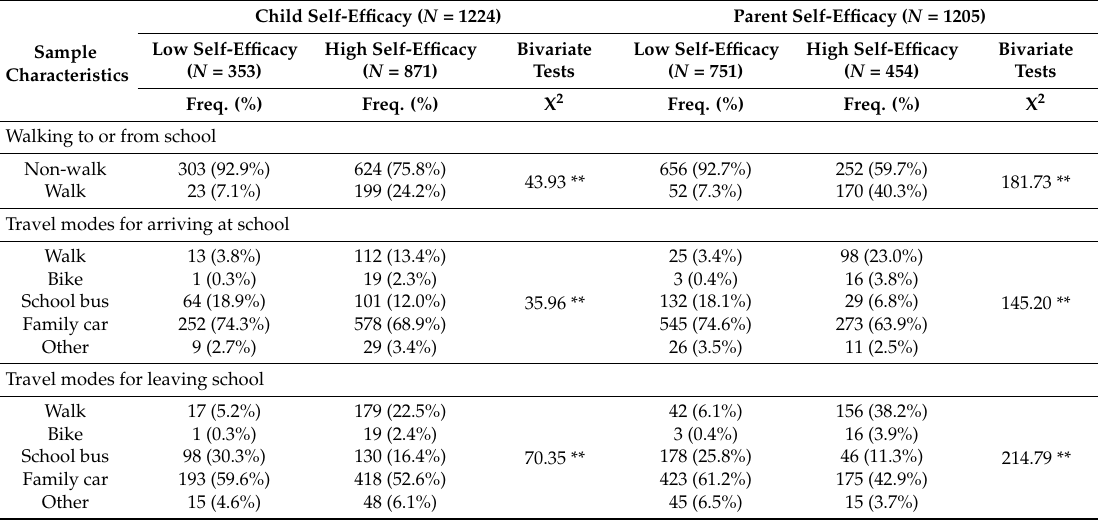
Table 2. Travel modes by child and parent self-efficacy and bivariate